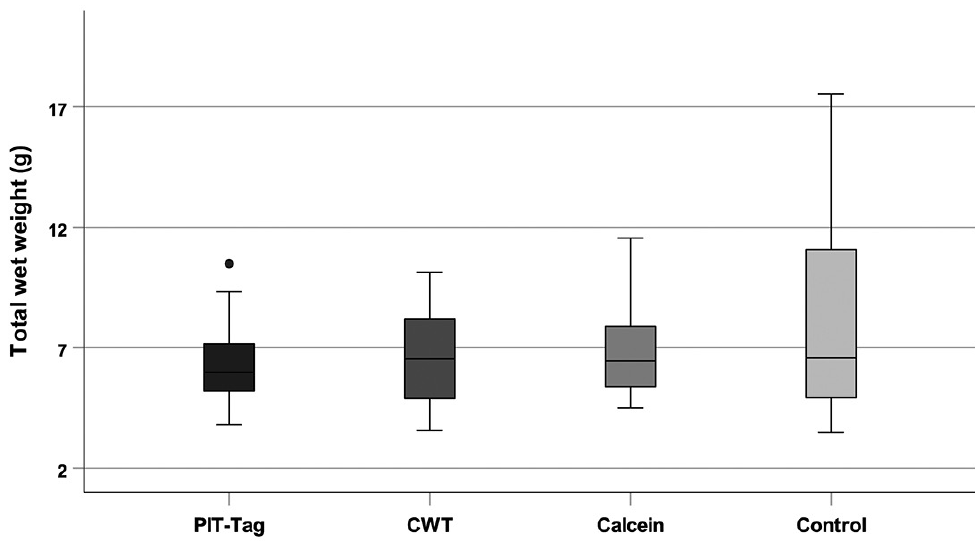
Fig. A3. – Boxplot representing the final total wet weight of Paracentrotus lividus at the end (T2) of a 60-day rearing in the laboratory using PIT-tags, coded wire tags (CWTs), calcein and an untagged control. The boxplot represents the minimum, maximum, median, first quartile and third quartile of the data set and the dot represents an outlier.